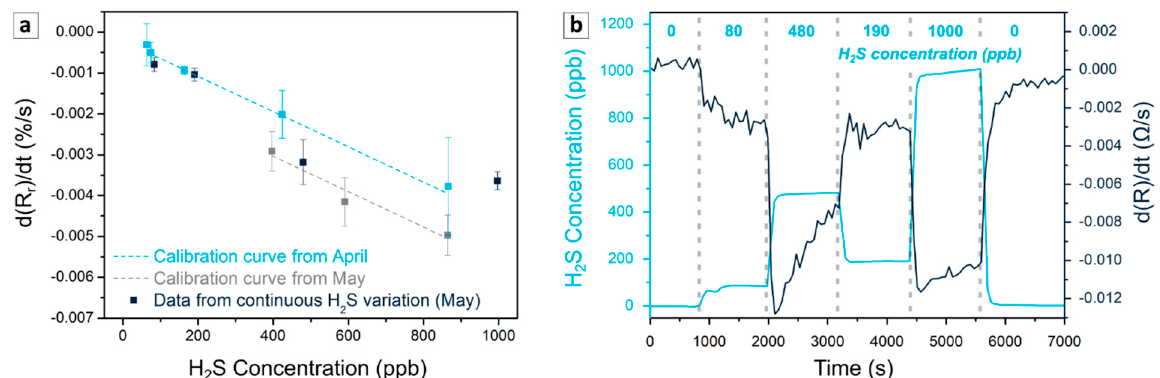
Figure 7. Signal variation of PAni-SnCl 2 composites containing 3 wt% of PEDOT:PSS during the continuous variation of H 2 S concentration. ( a ) Comparison of the relative derivative from the continuous variation of H 2 S concentration with the calibration previously established. ( b ) Variation of the concentration given by analyzer and the derivative of the signal from the sensors as a function of time.